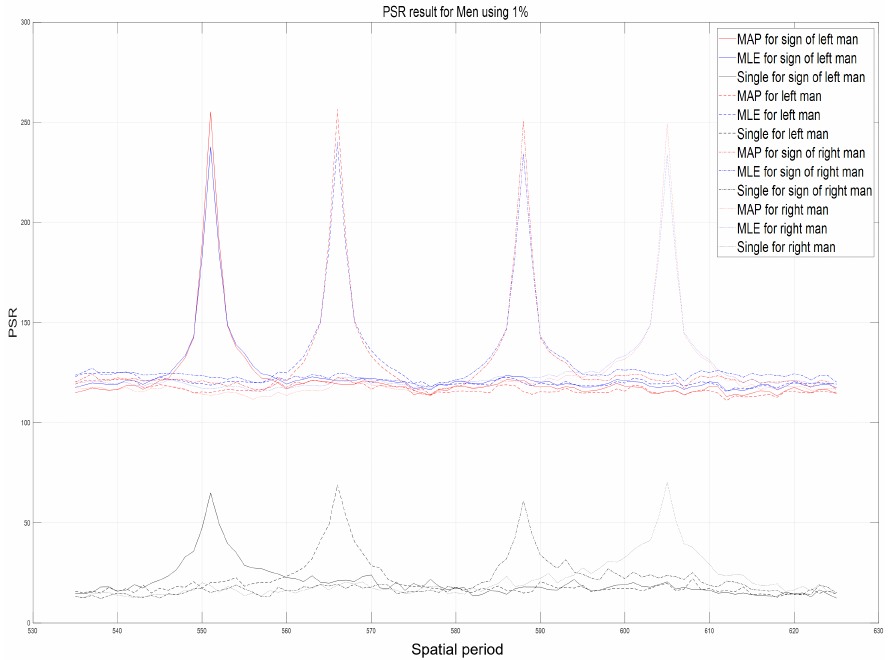
Figure 15. Peak sidelobe ratio (PSR) results of Men objects via various spatial periods at reconstruction depths by single observation photon counting method, N = 100 observation MLE, and N = 100 observation MAP with 1% photon